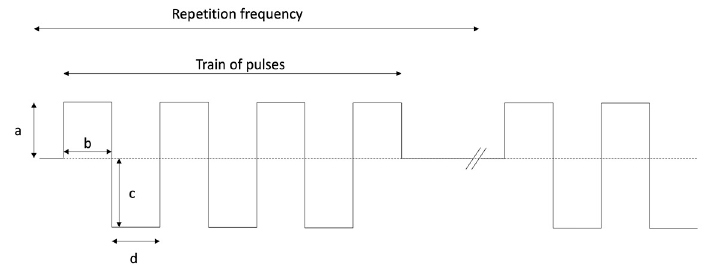
Figure 1. Example of the electric signal generated by a stimulator. a = positive amplitude; b = positive width; c = negative amplitude; d = negative